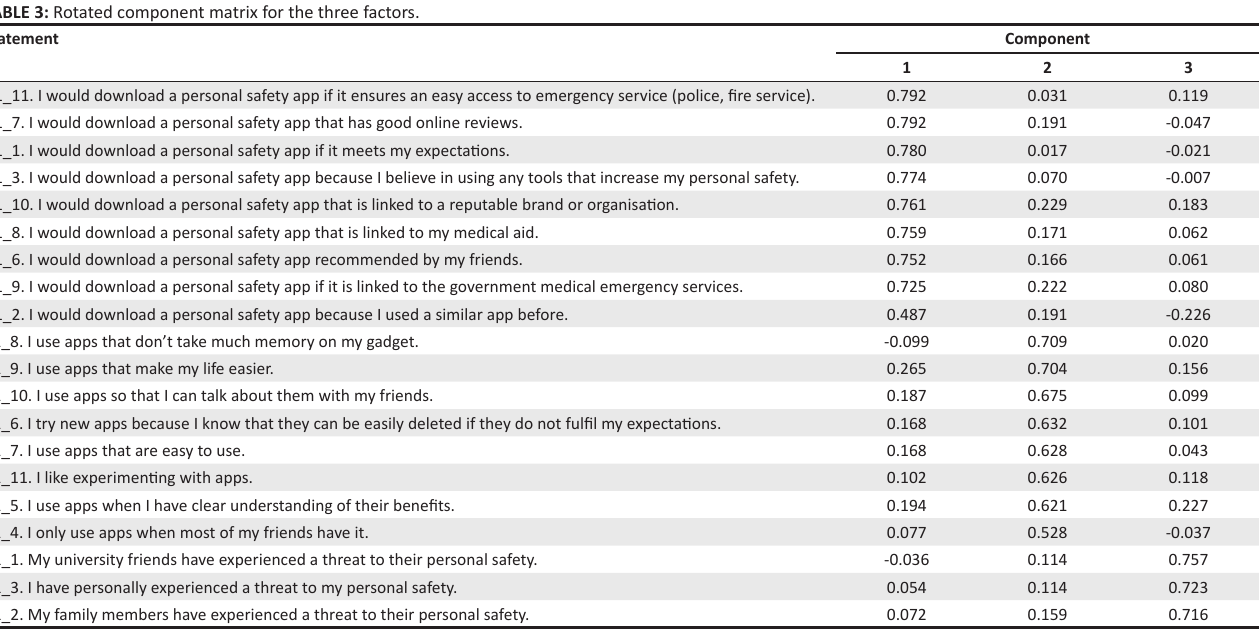
TABLE 3: Rotated component matrix for the three factors.